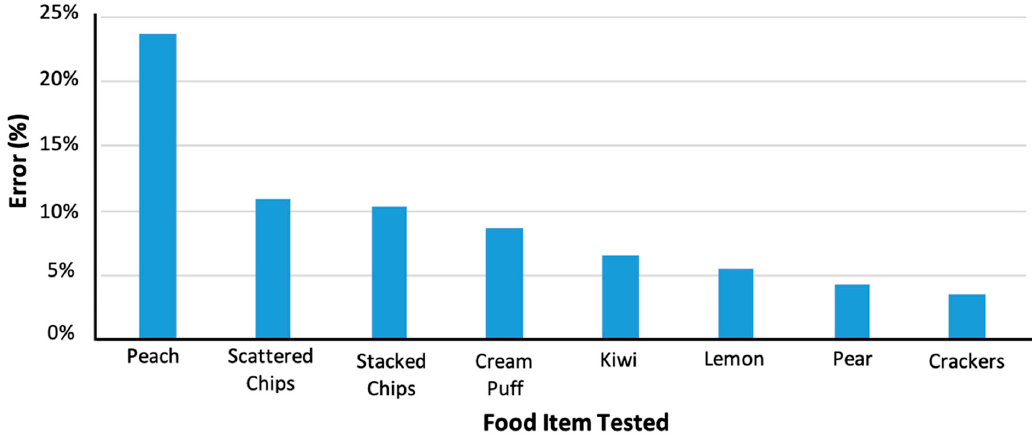
Figure 16. Percentage error for the number of dots detected when compared to manual dot detection.